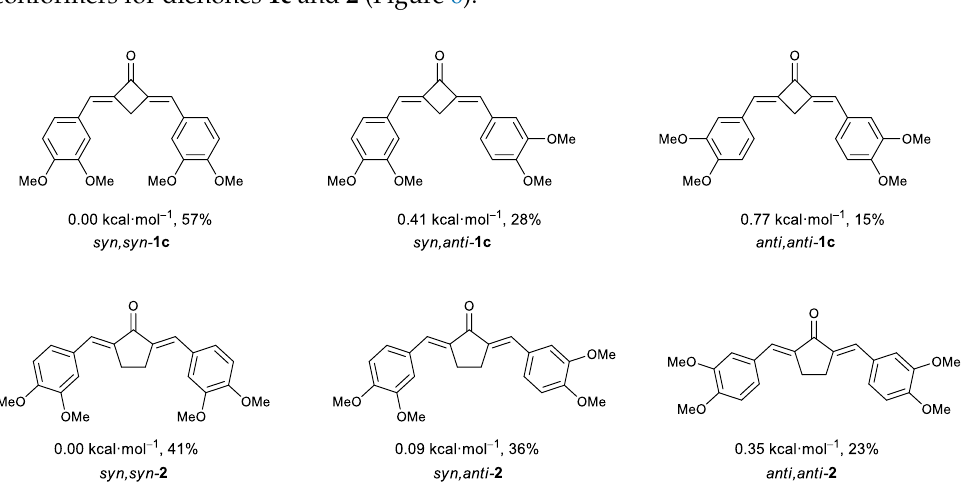
Figure 6. Possible conformers of ( E , E )-dienones 1c and 2 and their stability relative to the most favorable syn , syn -conformers. The mole fractions of conformers at room temperature in CD 2 Cl 2 are given in %; the values were determined by the Boltzmann equations using the relative energies of the conformers.